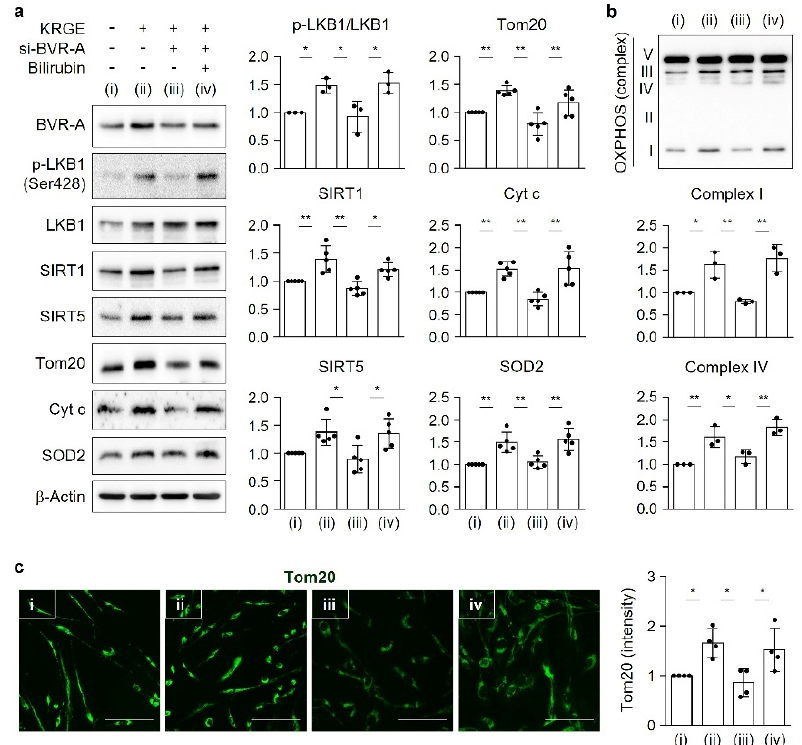
Figure 6. Exogenous bilirubin recovers KRGE-modulated mitochondrial function in BVR-A-depleted astrocyte cells. ( a – c ) Astrocytes were transfected with control or BVR-A siRNA. Then, KRGE (0.5